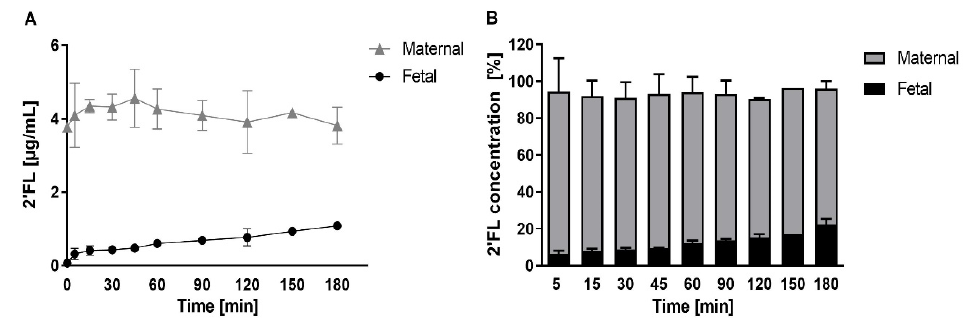
Figure 4. Maternal to fetal 2 ′ FL transfer across the placenta. Ex-vivo placenta perfusion experiments ( n = 3) were performed in presence of 2 ′ FL (5 μ g/mL) in the maternal circulation. ( A ) 2 ′ FL concentrations (± SD) were determined in maternal and fetal circulation after 5, 15, 30, 45, 60, 90, 120, 150, 180 min by HPLC. ( B ) 2 ′ FL recovery was calculated in maternal and fetal samples at distinct time points. Data are expressed as percentage (± SD) of initial concentration in the maternal circulation.